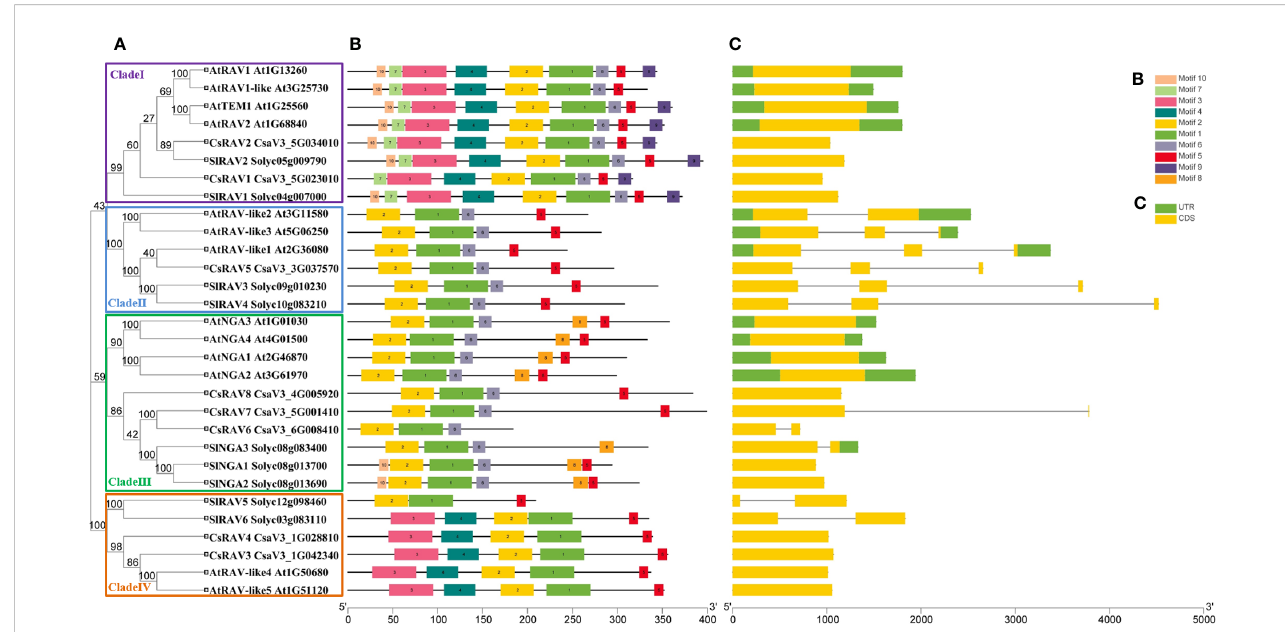
FIGURE 2 The analysis of phylogenetic relationships, conserved motifs and gene structures in RAV genes from cucumber, Arabidopsis and tomato. (A) A phylogenetic tree containing nine SlRAVs, 13 AtRAVs and eight CsRAVs was constructed by MEGA 7.0 software and divided into four clades named I, II, III and IV, respectively. (B) The conserved motifs in RAVs were identi fi ed using MEME online program. Ten conserved sequences were presented in Supplementary Figure S2. (C) Exon-intron structure of RAV